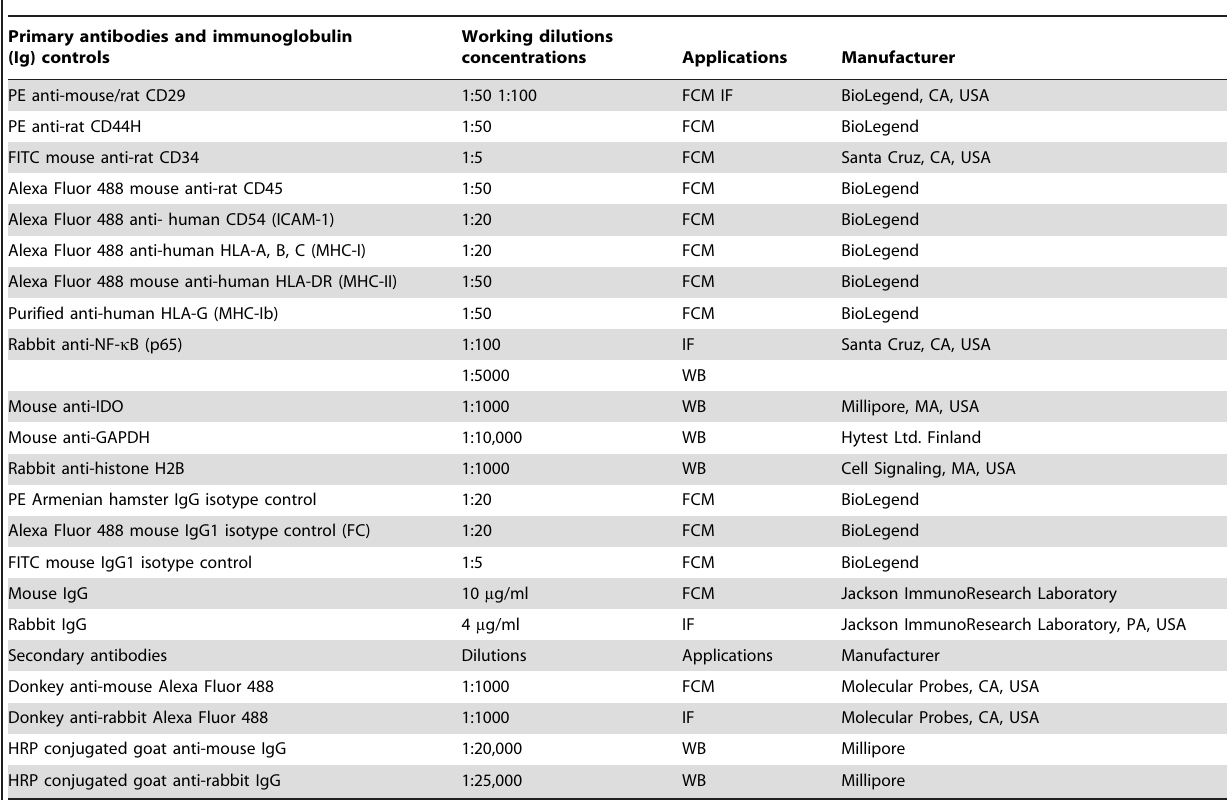
Table 6. Antibodies, conjugates and immunoreagents.